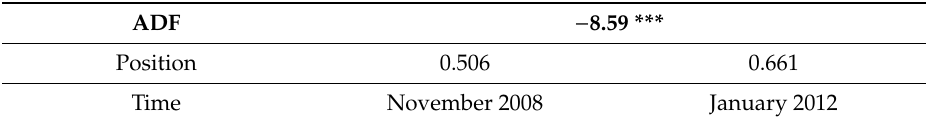
Table 8. Hatemi-J cointegration test results.